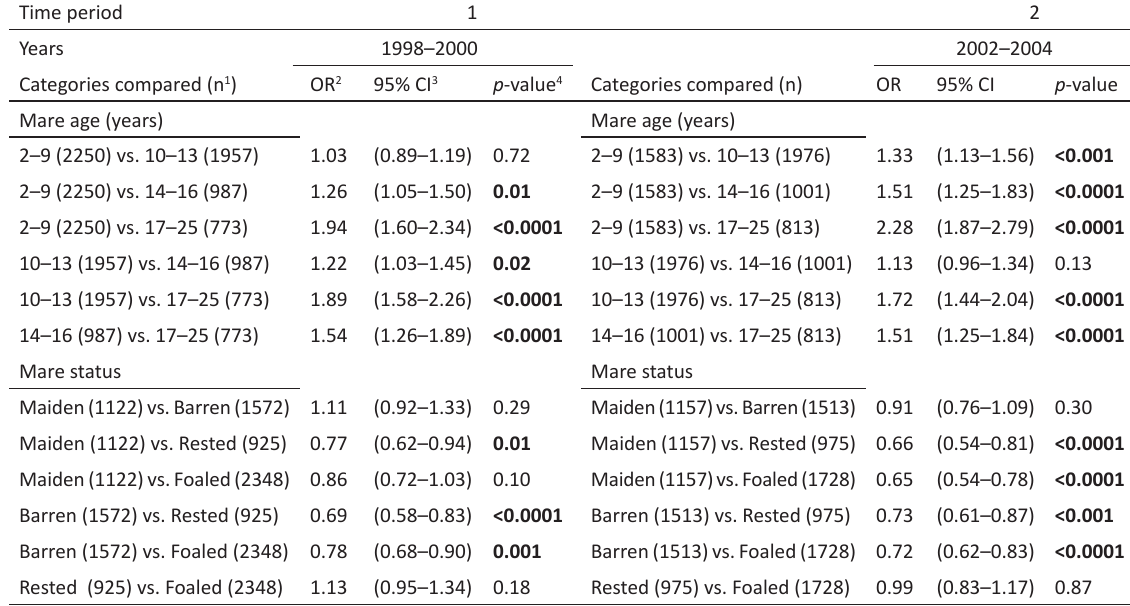
Table 3. Multivariable logistic mixed model results for mare age and mare status groups to test differences in foaling rates of Finnhorse mares within two time periods. Models were performed separately for both periods and adjusted for mating type, book size (mares/ stallion/year), and their interaction. Mare and stallion were incorporated as random effects. An odds ratio (OR) >1 indicates that the foaling rate (FR) in the first-mentioned group was higher than in the comparison group, and 0<OR<1 indicates the opposite.